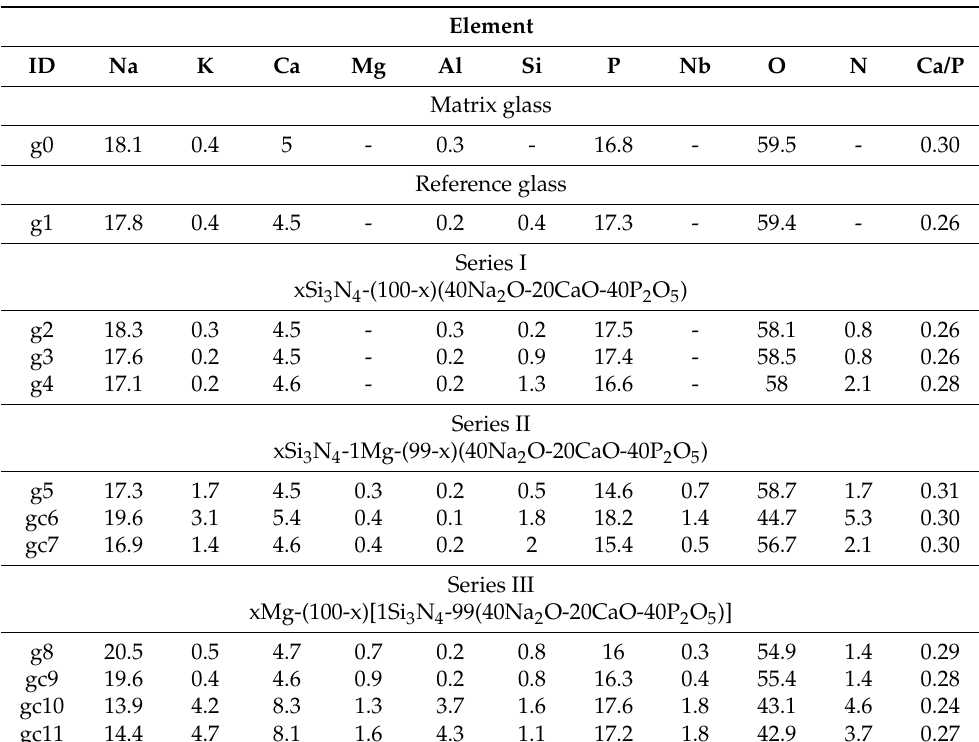
Table 1. EDX chemical composition (at%) of samples checked on their fresh fractures. The label g before the sample number referred glass, while gc referred glass-ceramic material. The analysis accuracy is ± 5% of value